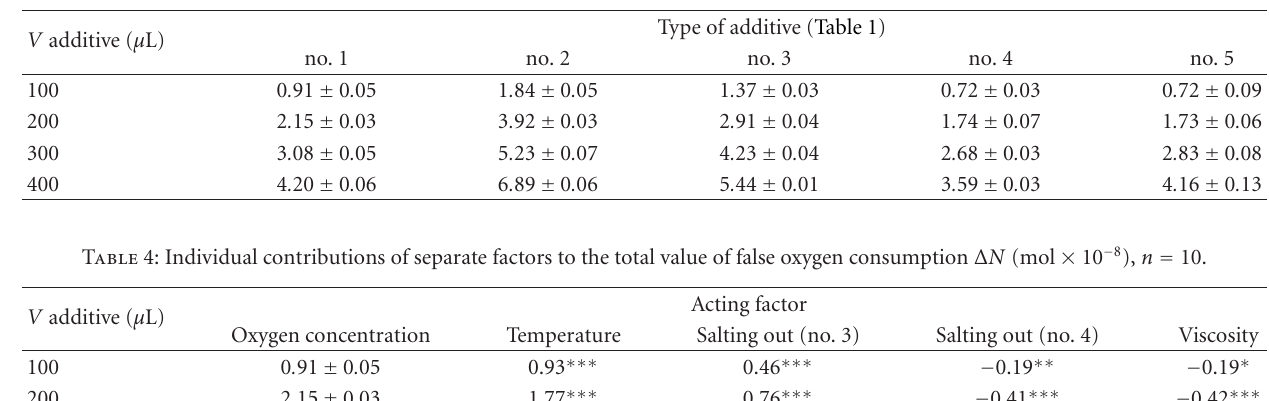
Table 3: False oxygen consumption Δ N (mol × 10 − 8 ), caused by the introduction in the incubation medium of various oxygen-free additives (mean ± SE, n = 10).